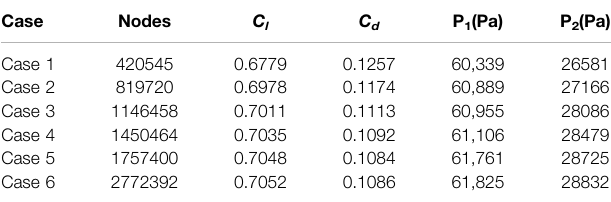
TABLE 1 | Veri fi cation of grid independence.